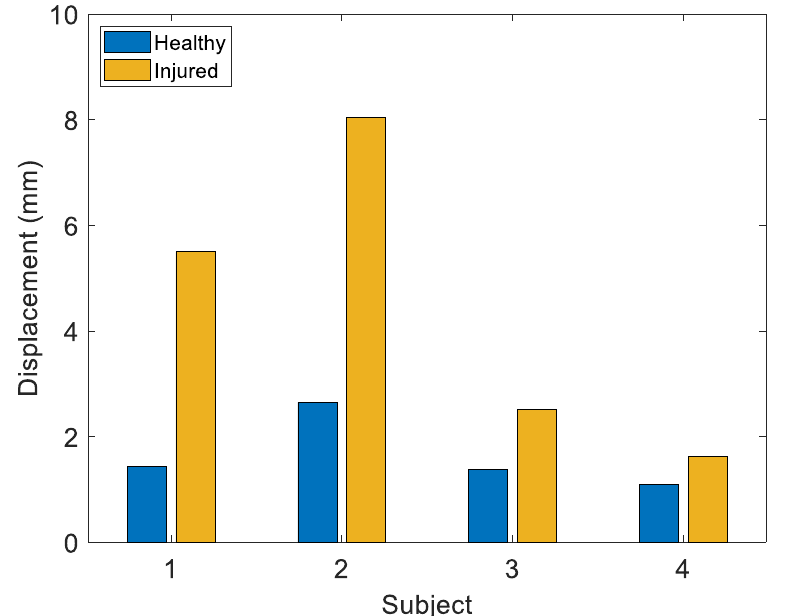
Figure 12. Maximum displacement for Stretch Sensor 3 in the Drawer test for the healthy and injured knees in four subjects.